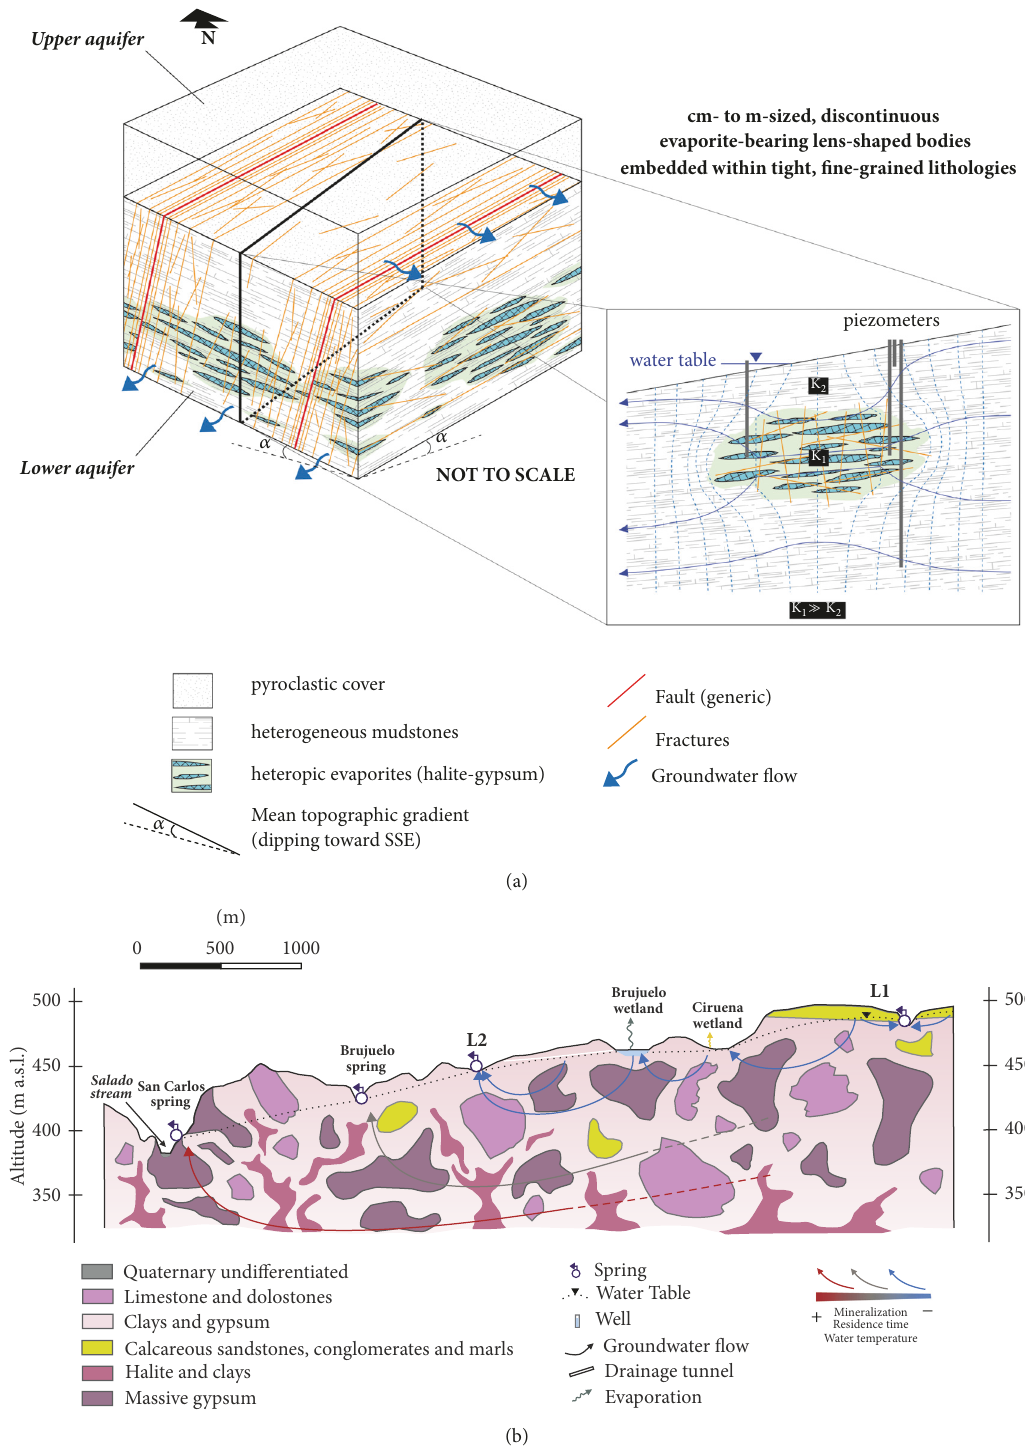
Figure 8: (a) Conceptual hydrogeological model of heterogeneous media characterized by evaporate-bearing fine-grained succession of Pozzo del Sale and (b) idealized conceptual model of Brujuelo area (modified by M´arques et al.